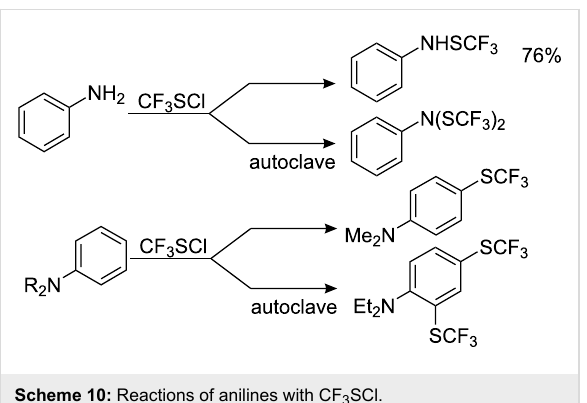
Scheme 10: Reactions of anilines with CF 3